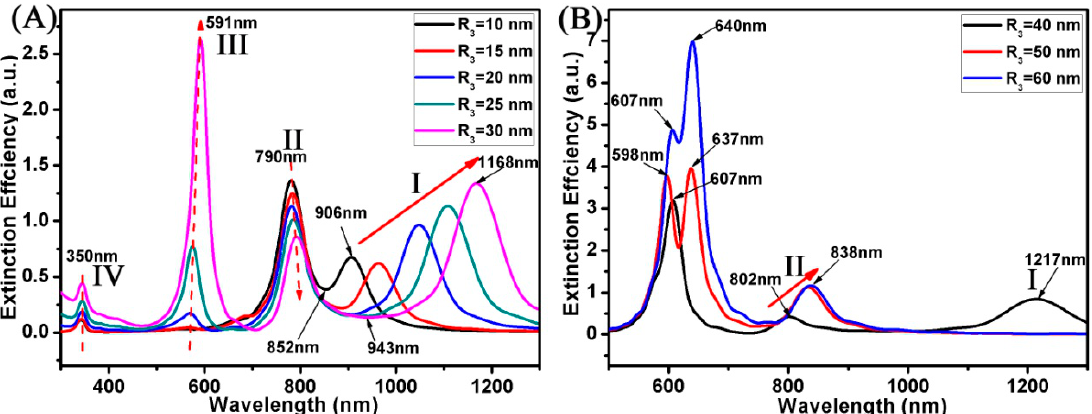
Figure 6. ( A , B ) Spectra calculated for the Au ring ‐ disk nanostructures with different R 3 . The R 1 and R 2 of the ring was unchanged (R 1 = 20 nm; R 2 = 30 nm). The H of the ring ‐ disk nanostructures was unchanged (H 1 = H 2 = H = 10 nm). The R 3 of the disk increased from 10 to 60 nm.